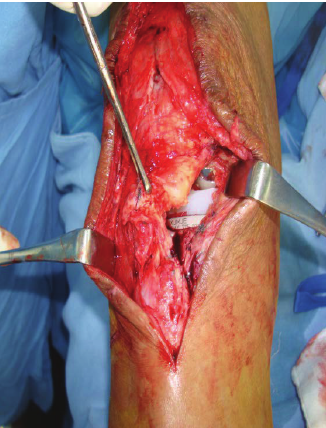
Figure 1: Showing patellar tendon avulsion from distal end with TKA implant in situ.